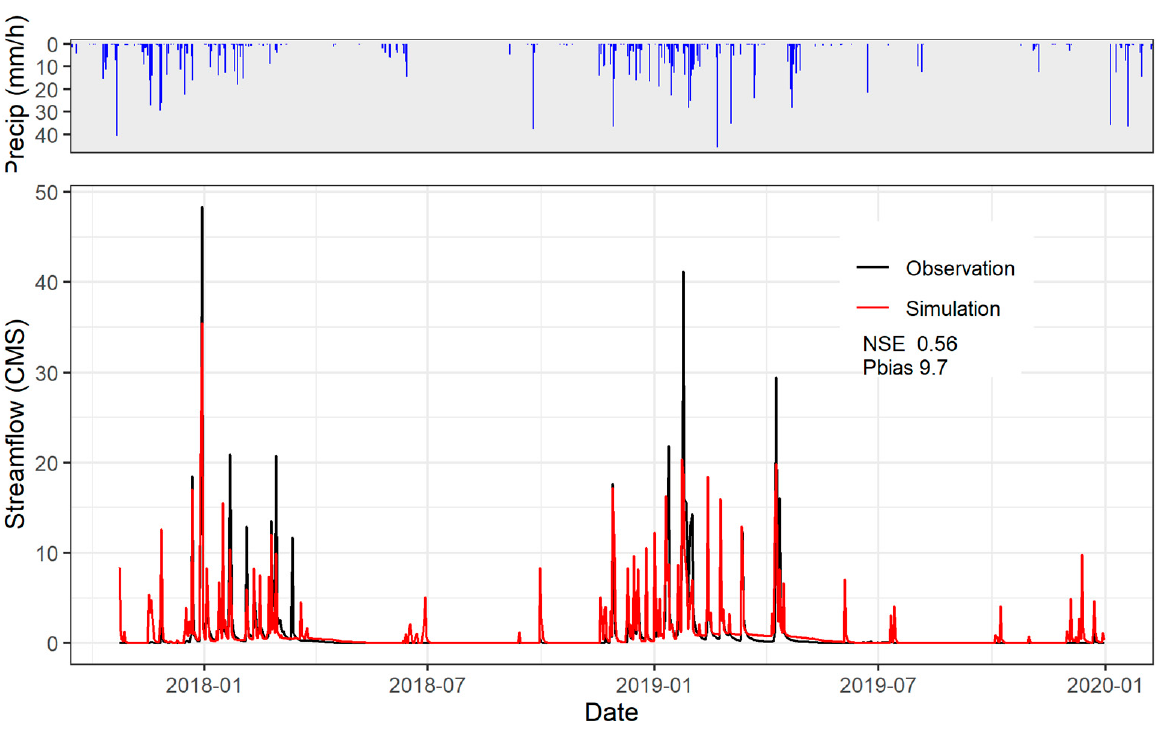
Figure 6. Measured and simulated daily discharge at Tsiknias River gauging station during validation (2017–2019).